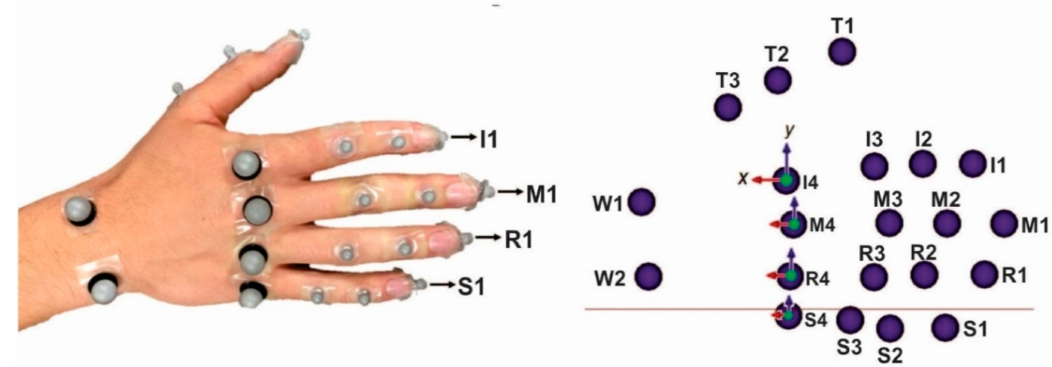
Figure 8. Location of the markers and the digital reconstruction of the hand.